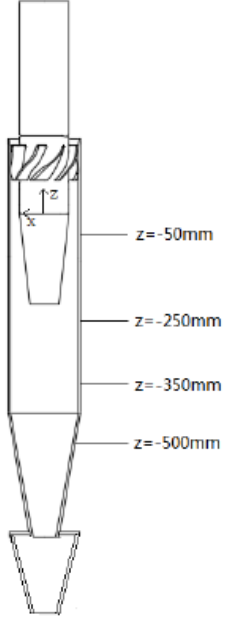
Figure 5. Dimensions of referenced section.